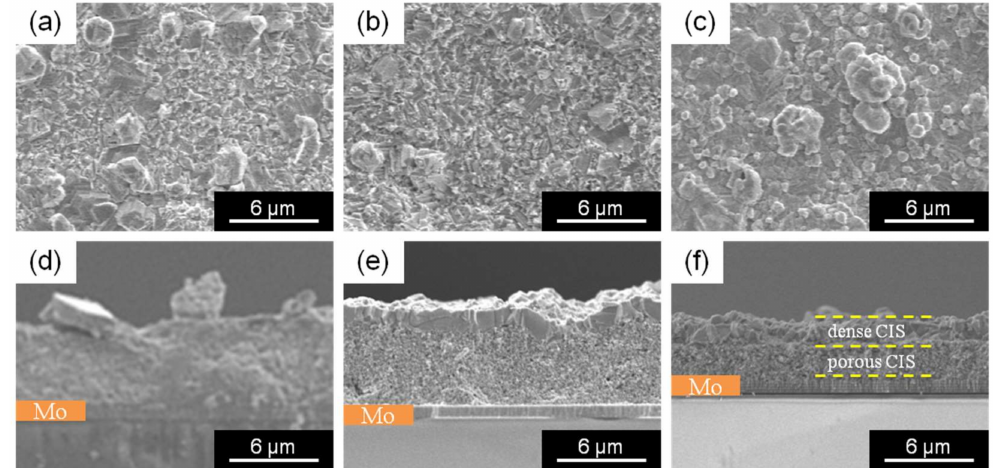
Figure 9. SEM images (surface morphology and cross-section) of the CIS solar cell based on Cu-In nanoparticles using ( a , d ) PVP(K16-18) and Cu/In = 0.91, ( b , e ) PVP(K25) and Cu/In = 0.9, ( c , f ) PVP(K25) and Cu/In =